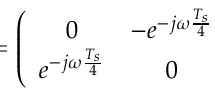
Figure 2. Spectrum analyzing results of the STI. ( a ) Input from port 1; and ( b ) input from port 2.